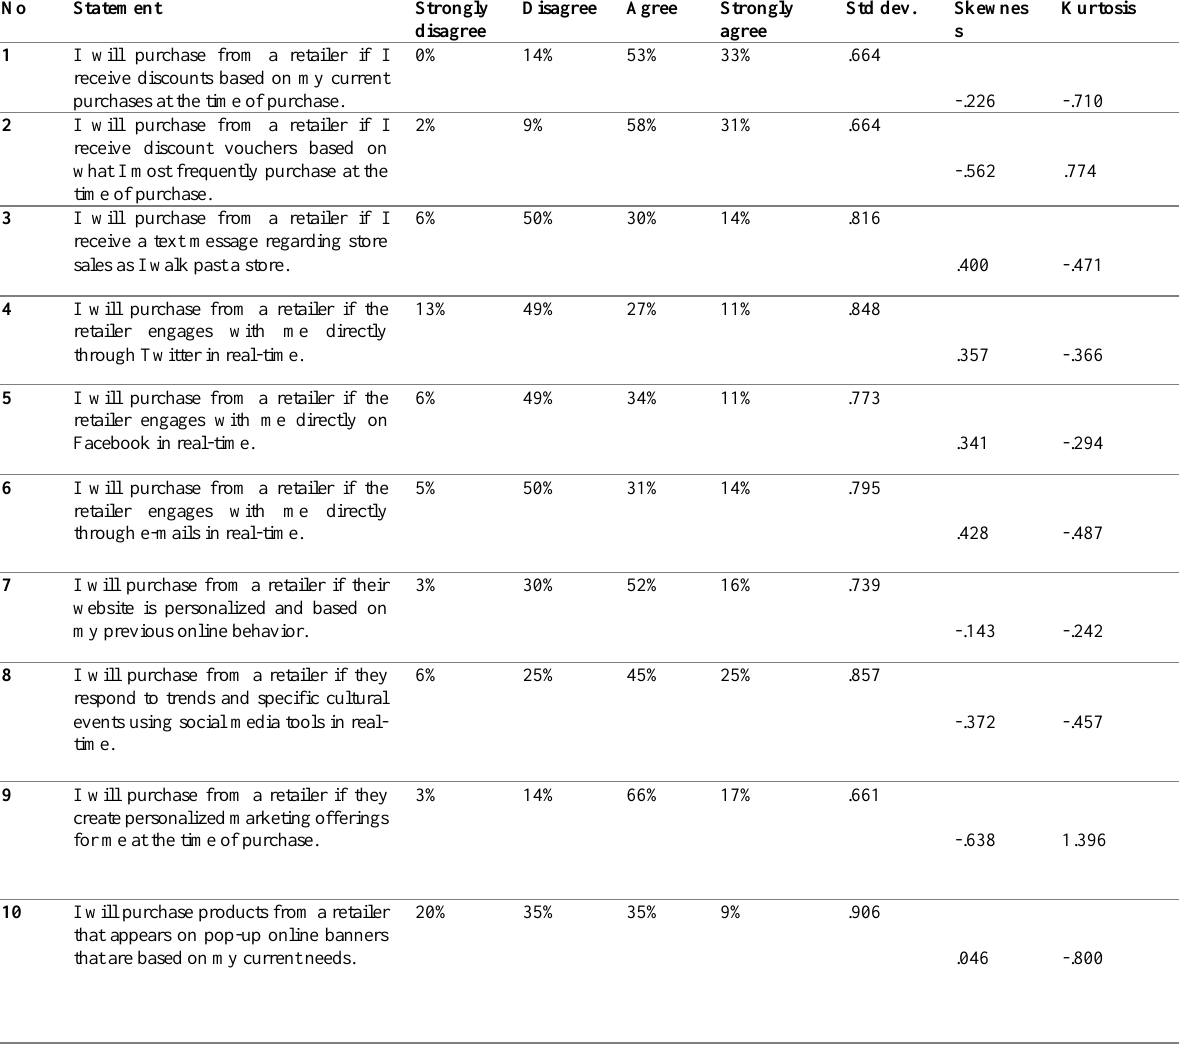
Table 5: Consumer behavior towards RTM